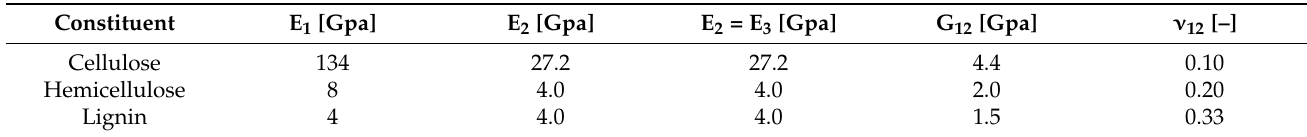
Table 3. Constituent properties of Jute Fiber [36].